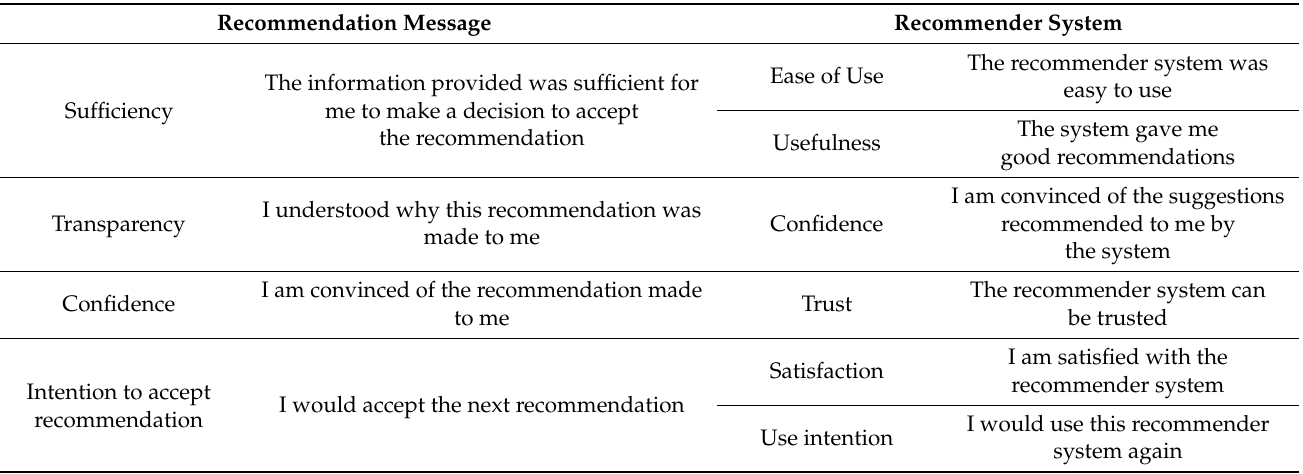
Figure 4. Example of Likert-scale question. Table 2. Measurement items